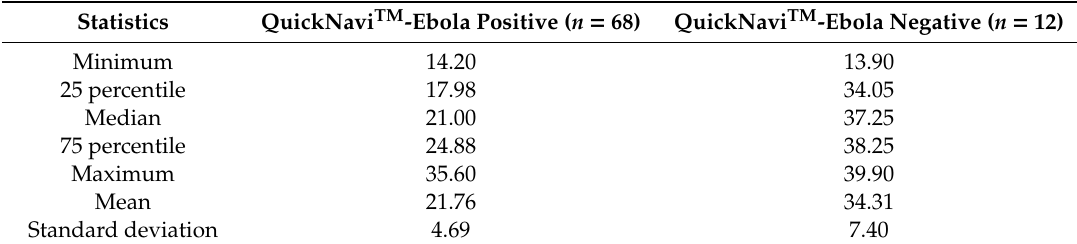
Table 4. Distribution CT values of QuickNavi TM -Ebola positive and negative